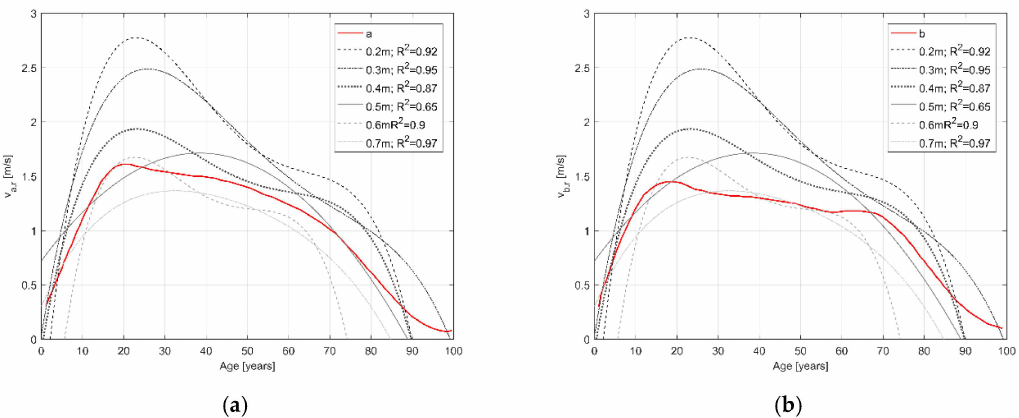
Figure 13. Maximum dimensional age-evacuation speed (m/s) model in running conditions, for the different D values according to a polynomial (4th degree) regression model, performed on all the experimental pairs (male and female together): ( a ) compared to the curve a [46]; ( b ) compared to the curve b [43].